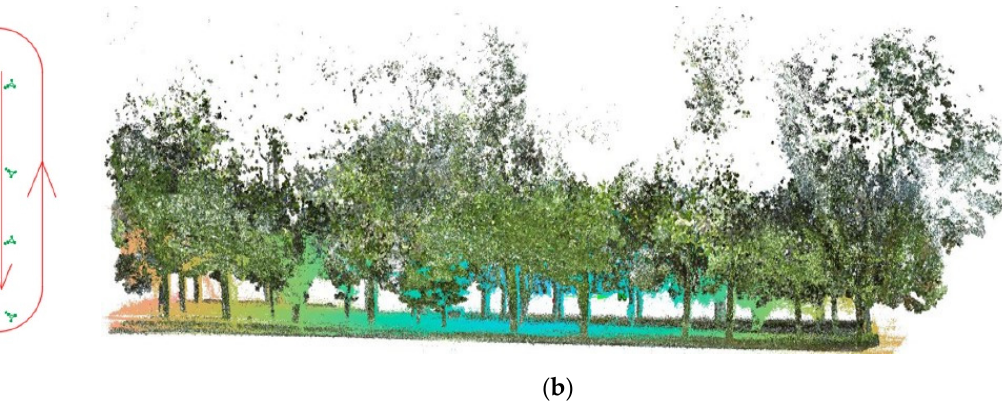
Figure 14. Data fusion diagram. (( a ) shows path fusion; ( b ) shows point cloud